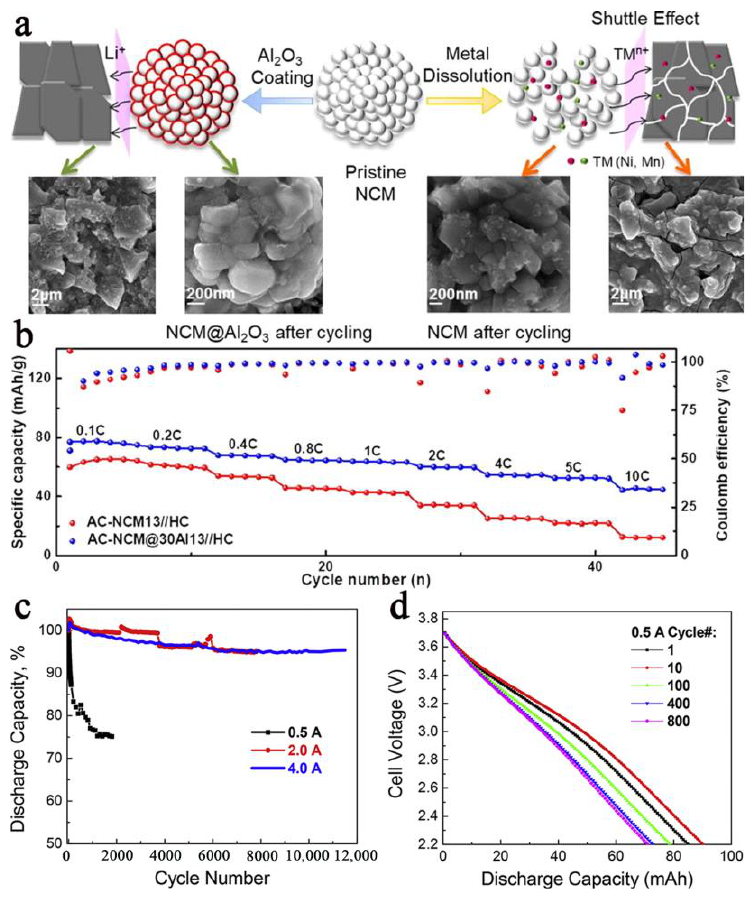
Figure 14. NCM-based LIBC: ( a ) Capacity failure mechanism; ( b ) Rate performance and cycle performance [93]. ( c ) Cycle performance; ( d ) Discharge profiles at different currents